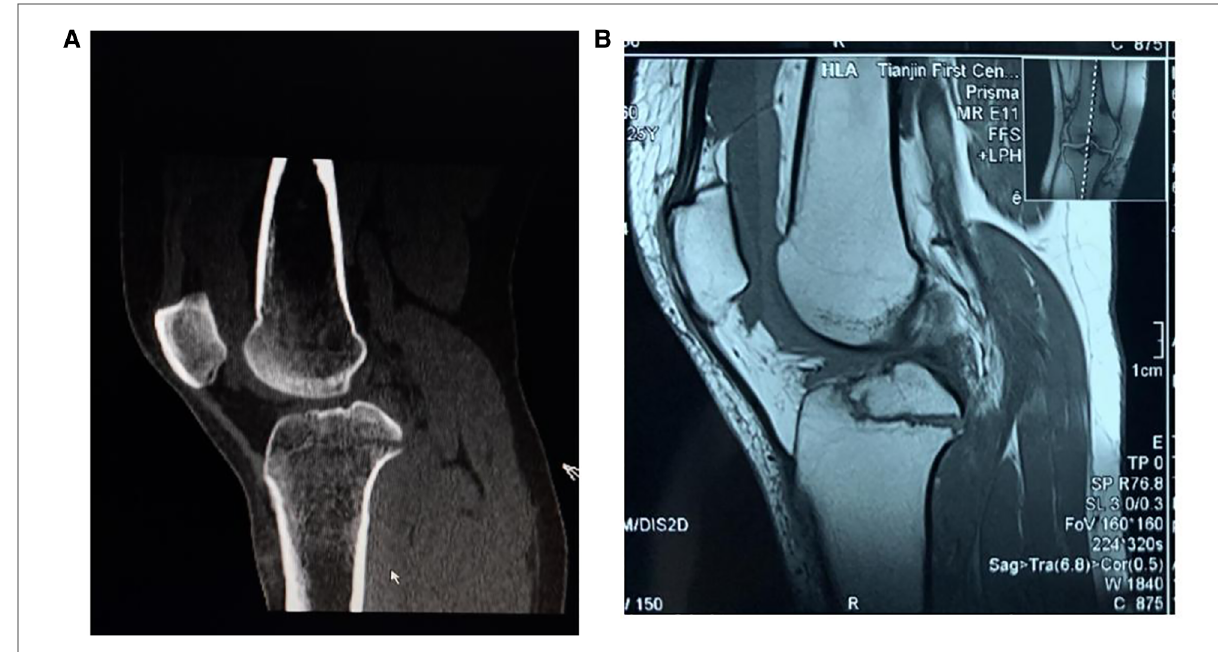
FIGURE 2 Preoperative radiograph of posterior cruciate ligament (PCL) avulsion fracture. ( A ) CT scanning showed the posterior cruciate ligament avulsion fracture. ( B ) MRI con fi rmed the fragment size and displacement of the PCL avulsion fracture.